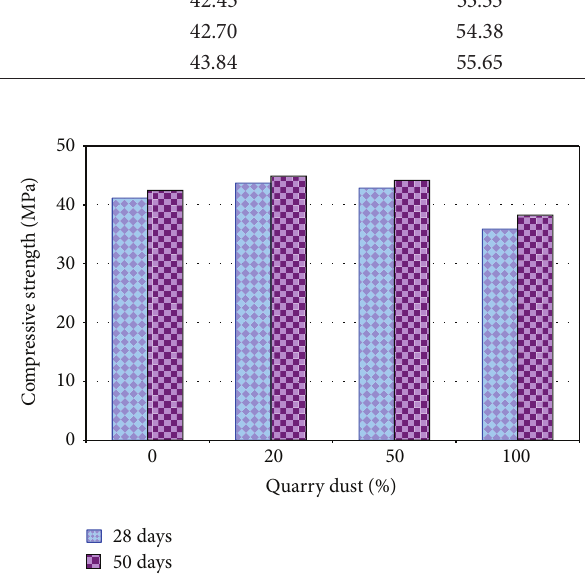
Figure 5: Variation of compressive strength with various percentage of quarry dust replacement in natural